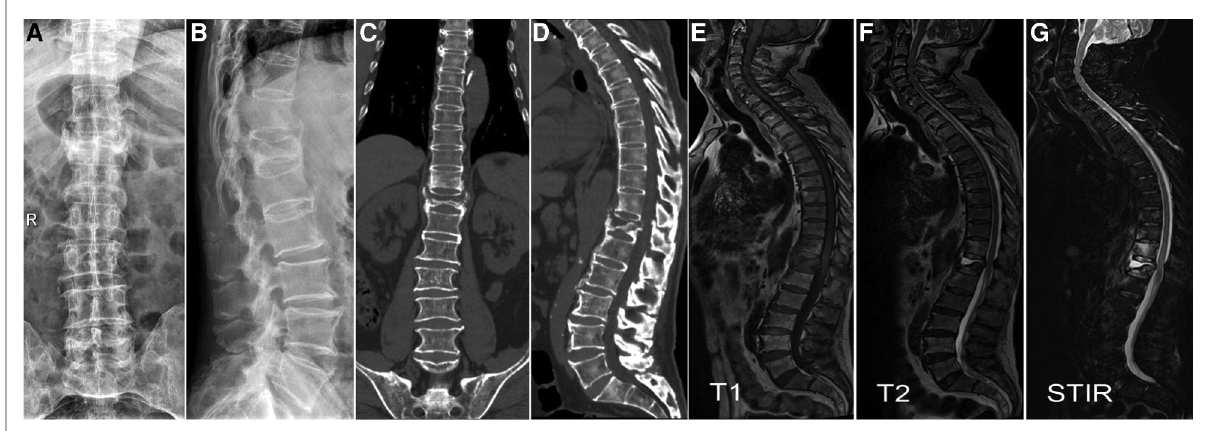
FIGURE 2 A 66-year-old male patient with T11 and T12 fractures ( A,B ). Coronal ( C ) and sagittal ( D ) CT showed intravertebral vacuum phenomenon (IVP). MRI showed well-de fi ned hypointensity on T1 ( E ), hyperintensity on T2 ( F ), and hyperintensity on short time inversion recovery ( G ), verifying the diagnosis of